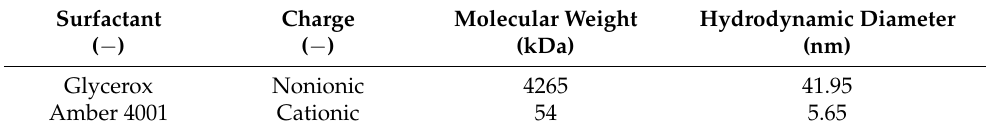
Table 1. Surfactant characteristics.